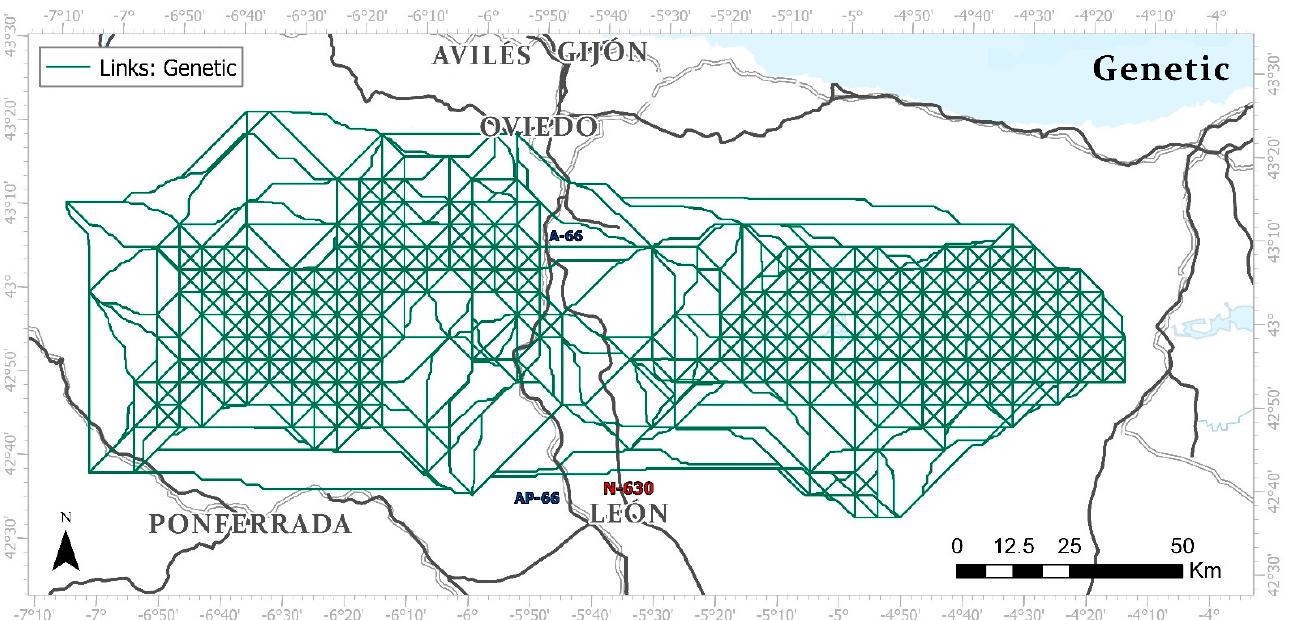
Figure A4. Links based on the least-cost modeling methodology for the genetic-multiplicative resistance surface.